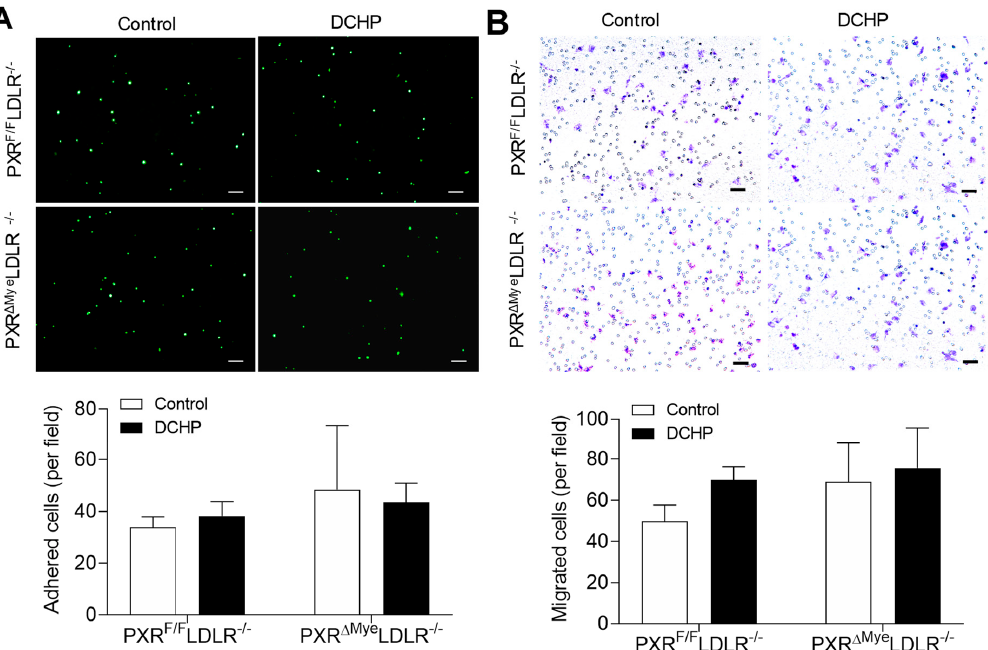
Figure 3. DCHP exposure does not affect the migration and adhesion properties of macrophages of PXR F/F LDLR − / − and PXR ∆ Mye LDLR − / − mice. Four-week-old male PXR F/F LDLR − / − and PXR ∆ Mye LDLR − / − littermates were treated with 10 mg/kg/day of DCHP or vehicle control daily by oral gavage for 12 weeks. ( A ) Peritoneal macrophages isolated from the PXR F/F LDLR − / − and PXR ∆ Mye LDLR − / − mice were labeled with calcein acetoxymethyl and cultured with primary porcine endothelial cell monolayer for 30 min. Adhered cells were then counted under a fluorescence microscope (scale bars = 100 µ m). ( B ) Peritoneal macrophages isolated from the PXR F/F LDLR − / − and PXR ∆ Mye LDLR − / − mice were seeded on the Matrigel-coated transwell filters. Cells that infiltrated and migrated to the underside of the transwell were stained with hematoxylin and counted under the microscope (scale bars = 100 µ m). Quantitative analysis of the migrated and adhered cells was displayed below the representative images. Data are represented as mean ± SEM (n = 3).